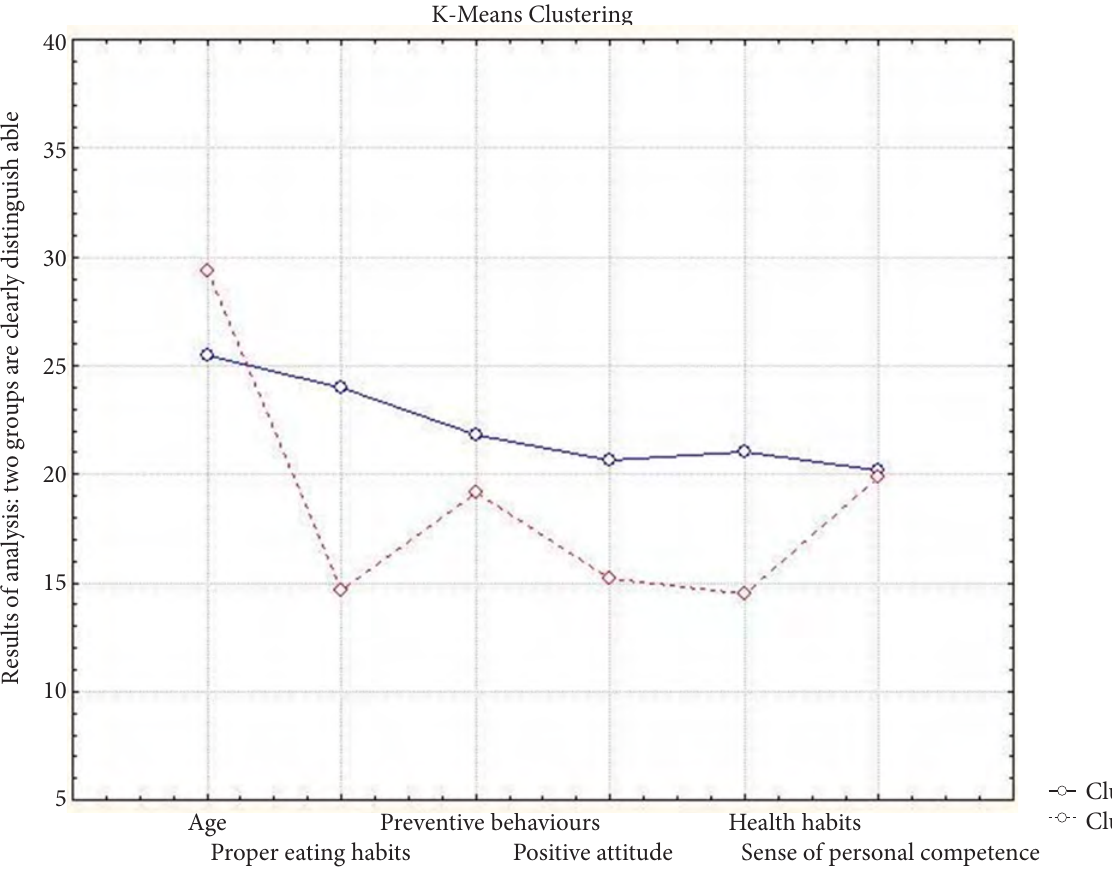
Figure 3. The diagram represents the result of cluster analysis with the use of k-means clustering senior team in cycle speedway sample group. Minimizing variance inside clusters-maximizing between clusters (N=12) (p<0.05)